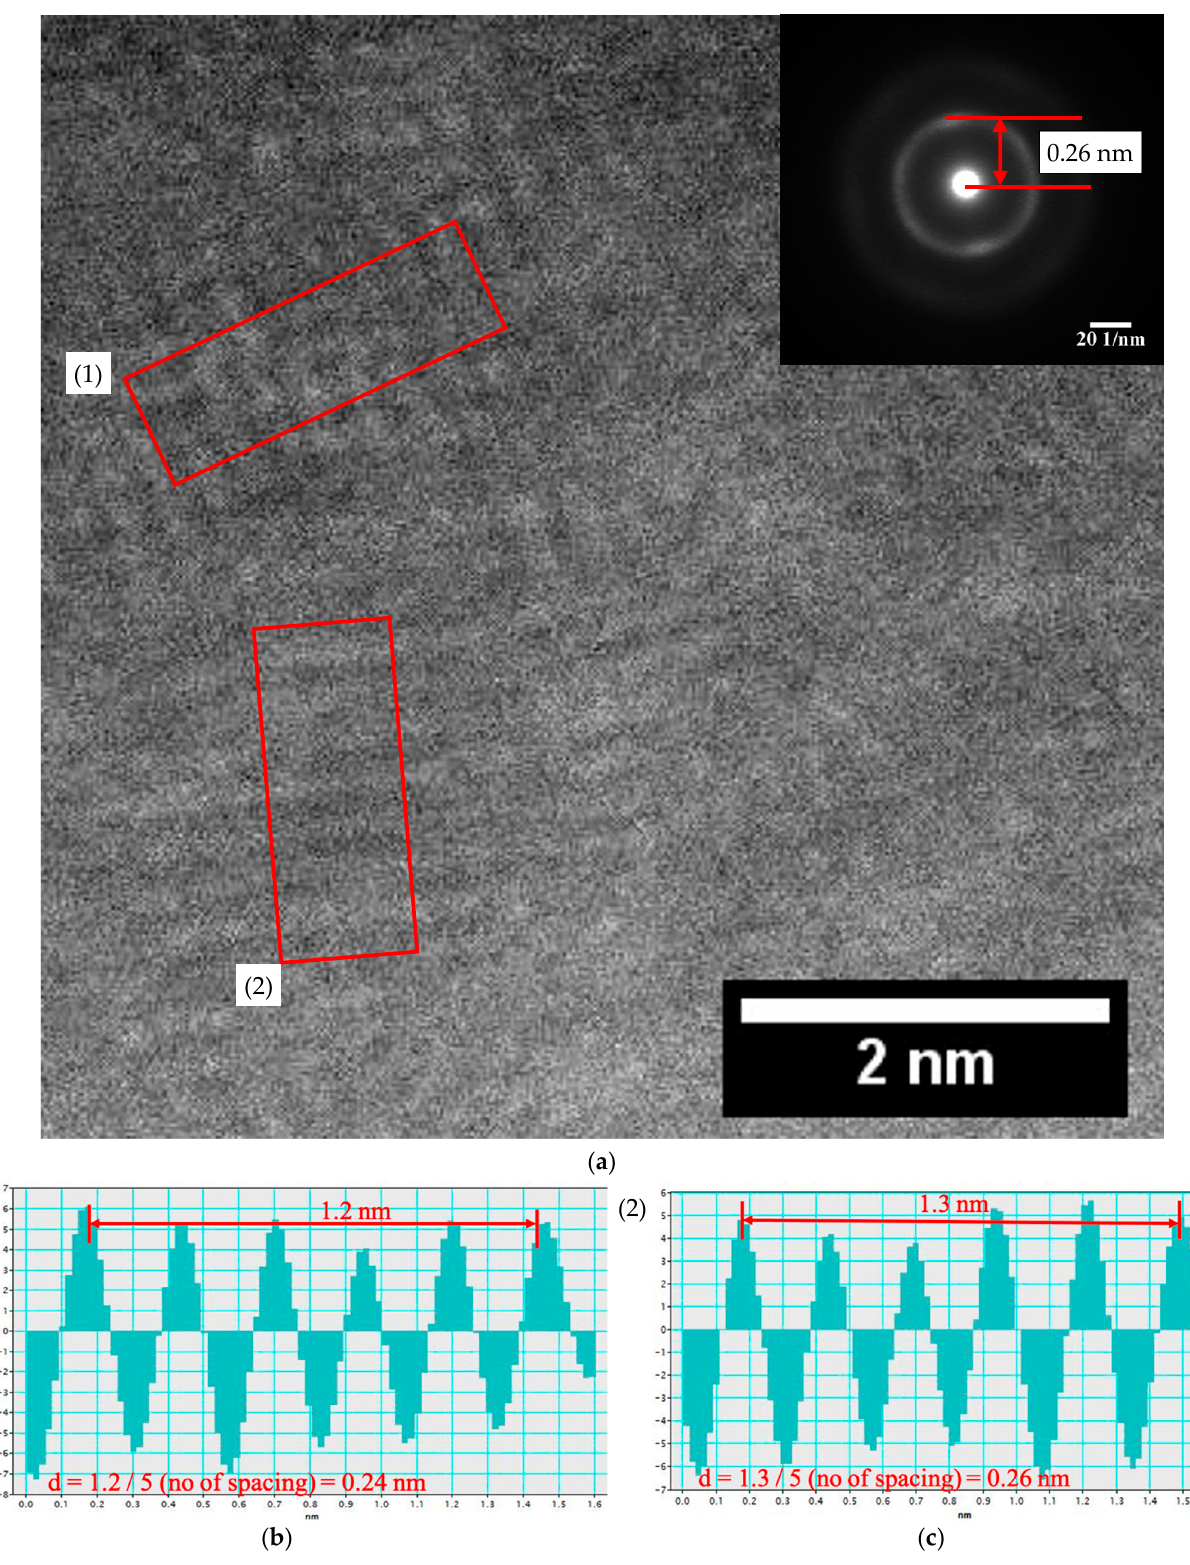
Figure 3. Cross-sectional scanning transmission electron microscopy (STEM) observation of Sample B. ( a ) Annular dark-field (ADF) STEM image with a selective area diffraction pattern (inset) acquired from the IGZO film under the TEM (parallel beam) mode and ( b , c ) lattice distance in two regions of ( a ).